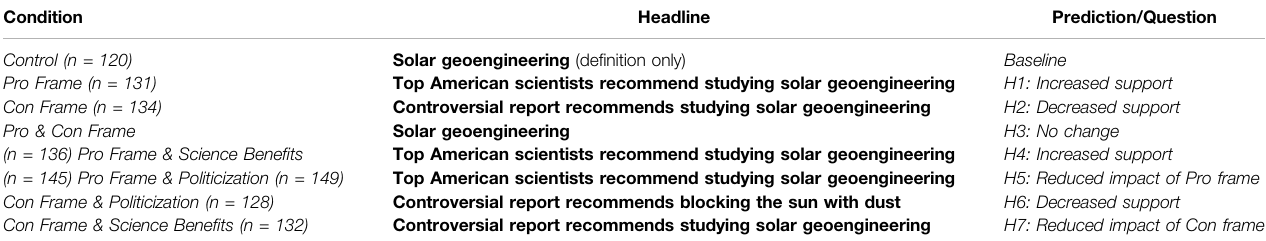
TABLE 1 | Experimental Design and